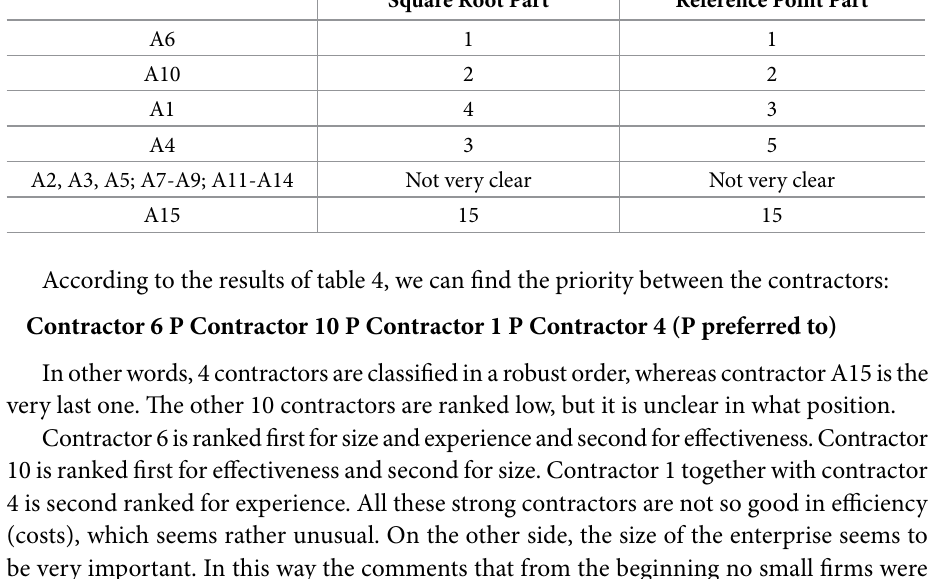
moora square root